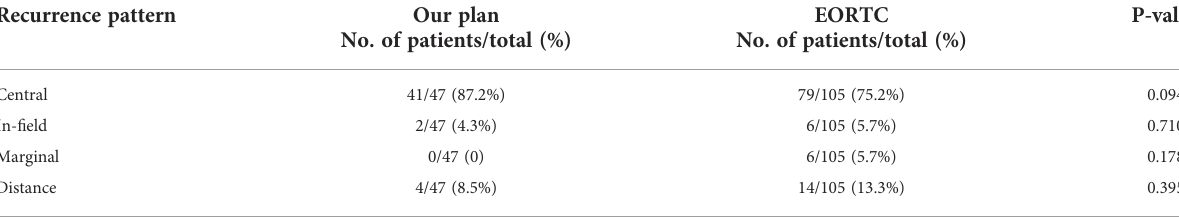
TABLE 3 Comparison of pattern of relapse with different target delineation methods.